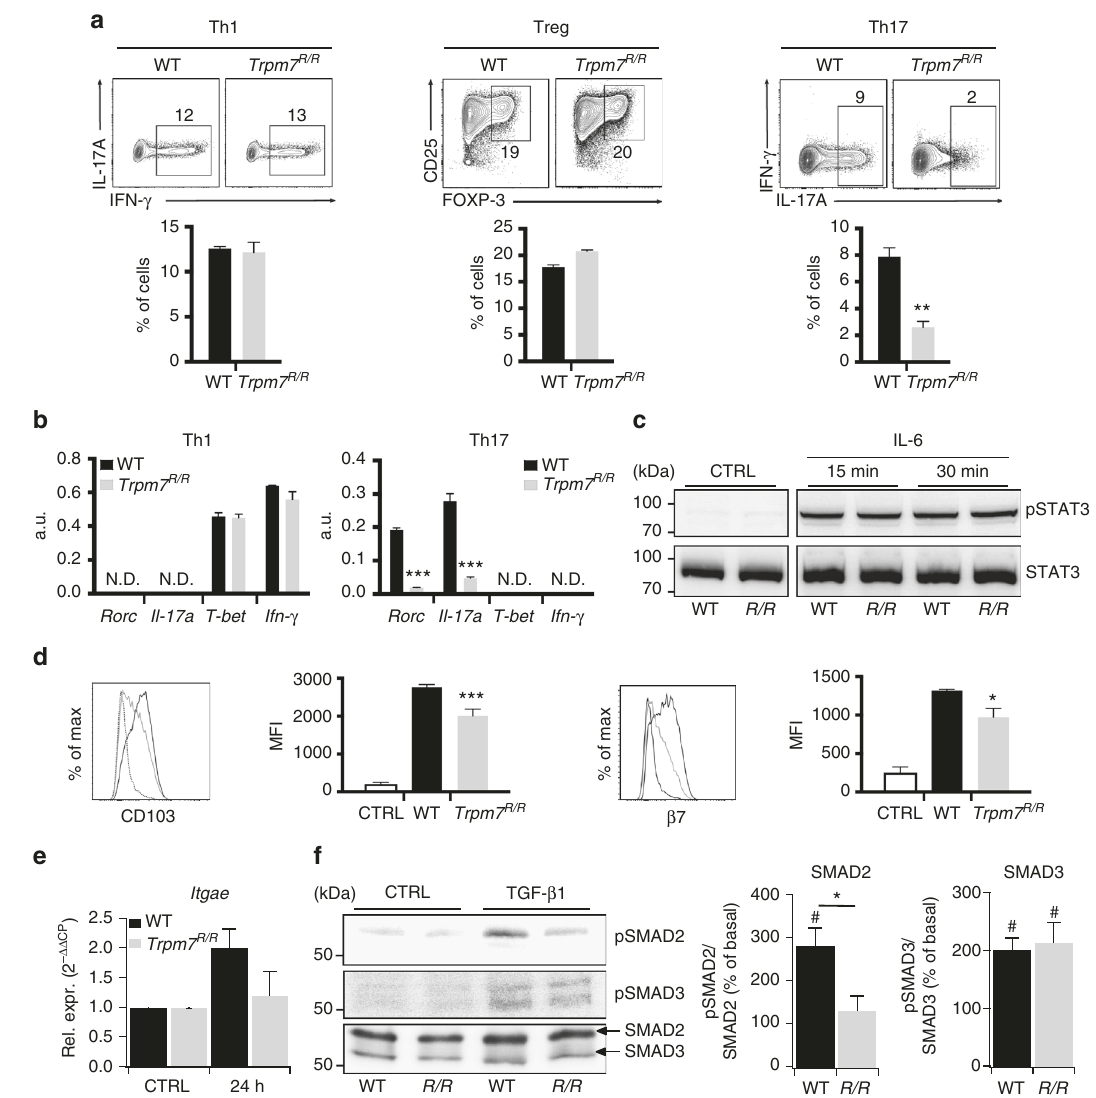
Fig. 5 Trpm7 R/R T cells have autonomous defects in in vitro Th17 polarization and CD103 upregulation. a Representative dot plots and statistical analyses of IFN- γ , IL-17A, CD25 and FOXP3 expression in stimulated naive T cells under Th1, T reg or Th17-polarizing conditions after 5 days of in vitro culture. Percentages are shown in each gate, bar charts show mean percentages ± s.e.m. ( n = 4). b Quantitative real-time PCR of T-bet , ifn- γ , Rorc , and Il-17a expression in naive T cells stimulated under Th1 or Th17-polarizing conditions after 5 days of culture in vitro. ( n = 3). c Western blot analysis of STAT3 phosphorylation (Tyr705) of control and IL-6 treated WT and Trpm7 R/R ( R/R ) naive T cells, respectively. Blots are representatives of at least three independent experiments. d Histogram overlays and statistical analyses of CD103 and β 7 staining by fl ow cytometry in WT or Trpm7 R/R naive T cells stimulated with anti-CD3 ε /anti-CD28 in the absence or presence of TGF- β (10 ng ml − 1 ) for 4 days. Histograms show mean fl uorescence intensity (MFI) ± s.e.m. ( n = 4). Data are representative results of at least three independent experiments. e Quantitative real-time PCR of Itgae (CD103) in control (CTRL) and WT or Trpm7 R/R naive T cells stimulated with anti-CD3 ε /anti-CD28 in the presence of TGF- β (5 ng ml − 1 ) for 24 h. Data are shown as 2 − ΔΔ CP ± s.e.m. ( n = 3). f Western blot and statistical analysis of SMAD2 (Ser465/467) and SMAD3 (Ser423/425) phosphorylation. Blots are representatives of at least four independent experiments. The semi-quantitative analysis was done via ImageJ software and plotted as percent increase in intensity of pSMAD/total SMAD compared to control. Bar charts show mean percentages ± s.e.m. for SMAD2 and SMAD3 ( n = 4 – 5). A two-tailed Student ’ s t test was used with * p < 0.05; ** p < 0.01 and *** p < 0.001. To demonstrate a signi fi cant increase in TGF- β -induced SMAD phosphorylation compared to untreated controls a one-way ANOVA was used with # p < middle panel), while SMAD3 (Ser423/425) phosphorylation was TGF- β was shown to upregulate CD103 via SMAD and NFAT unaltered (Fig. 5f, middle row and right panel). Consistently, pathways in human T cells 28 , we addressed whether the TGF- β / SMAD2 translocation into the nucleus was impaired in Trpm7 R/R SMAD signalling pathway was affected by TRPM7 kinase activity, particularly as TGF- β /SMAD pathways are also crucial for the T cells compared to WT (Fig. 6a). Thus, we conclude that the polarization of CD4 + T cells into T H 17 cells 29 . Importantly, TRPM7 kinase regulates T H 17 differentiation and Itgae expres- western blot analysis of Trpm7 R/R naive CD4 + T cells treated with sion via TGF- β /SMAD2 dependent pathways. To further clarify the mechanism by which TRPM7 kinase 5 ng ml − 1 TGF- β 1 for 10 min revealed a strong and reduction in activity controls TGF- β /SMAD2 signalling, we performed an SMAD2 (Ser465/467) phosphorylation (Fig. 5f, upper row and